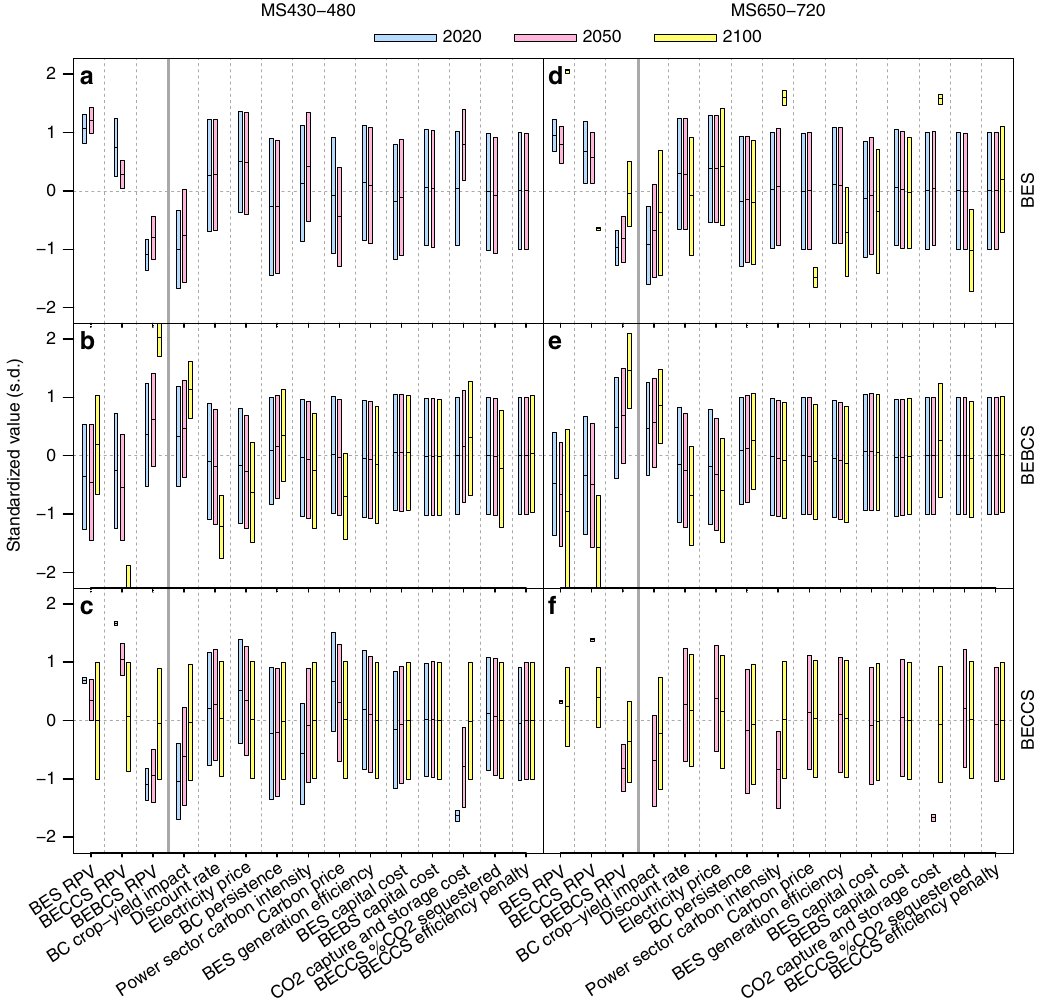
Figure 4 | Parameter ranges for which each technology has the highest relative net present value. The y axes are in units of standardized values for each parameter—that is, population mean of that parameter (in each scenario) is at zero, and height is measured in s.d.’s from the mean. ( a – c ) Relate to mitigation scenario MS430–480 (that is, atmospheric CO 2 concentration in 2100 is 430–480p.p.m. (IPCC Representative Concentration Pathway RCP2.6), consistent with a likely chance to keep temperature change below 2 (cid:2) C relative to pre-industrial levels), and d – f relate to MS650–720 (RCP 4.5, in which temperature change below 3 (cid:2) C is more unlikely than likely). Each panel is divided in two with three response variables (relative present values of BES, BEBCS or BECCS) on the left of the solid line, and the 12 most important independent parameters on the right. Each parameter has three bars (blue, pink and yellow) for parameter ranges in the years 2020, 2050 and 2100, respectively. Bars show the mean þ / (cid:2) 1 s.d. of the samples in which BES ( a , d ), BEBCS ( b , e ) or BECCS ( c , f ) has the highest RPV. Thus, the graph shows for each scenario (level of mitigation and year) how far each parameter must differ from the mean of that parameter in order to make each technology option the preferred one. Note that absent bars for BECCS in 2020 ( f ) and BES in 2100 ( a ) indicate that they are not economically viable at those